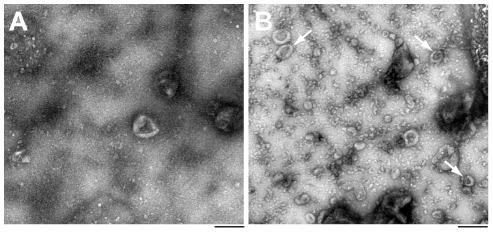
Exosomes are released from scrapie-infected B cells ex vivo.Spleens were dissected from 129/Sv×C57BL/6 mice 30 days after i.p. inoculation with 1% (w/v) RML I6200. MACS-isolated B lymphocytes were cultured under passive leakage (A) and basal (B) conditions essentially as described in Table 4 and tissue culture supernatants were isolated by sequential centrifugation (Materials and Methods). After centrifugation at 100,000× g for 2 h pellets were resuspended in PBS, absorbed onto carbon-coated grids and negatively stained with 1% uranyl acetate. Cup-shaped exosome-like membrane particles of different sizes (see arrows) are shown in Figure 1B. Twenty randomly recorded images (surface area: 2.82 µm2) from each condition were counted and the number of exosome-like particles (1.7±1.2 (A) and 22.8±6.5 (B) per surface area, p≪0.001) determined in a blinded manner. Scale bar: 0.2 µm.